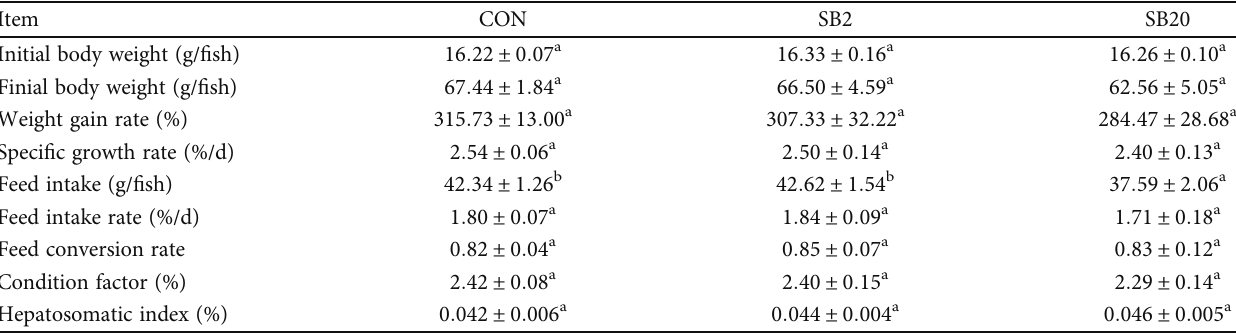
Table 3: E ff ects of two dosages of sodium butyrate on the growth performance of largemouth bass, Micropterus salmoides.